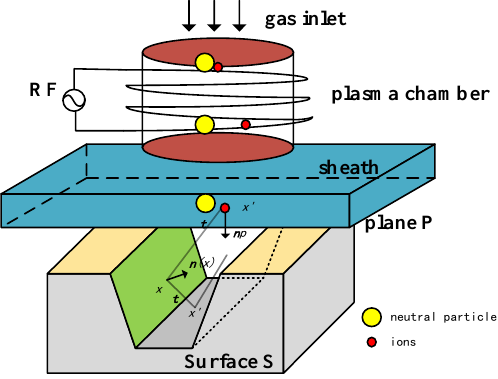
Figure 3. Schematic of three main phases in PECVD or plasma enhanced etching.